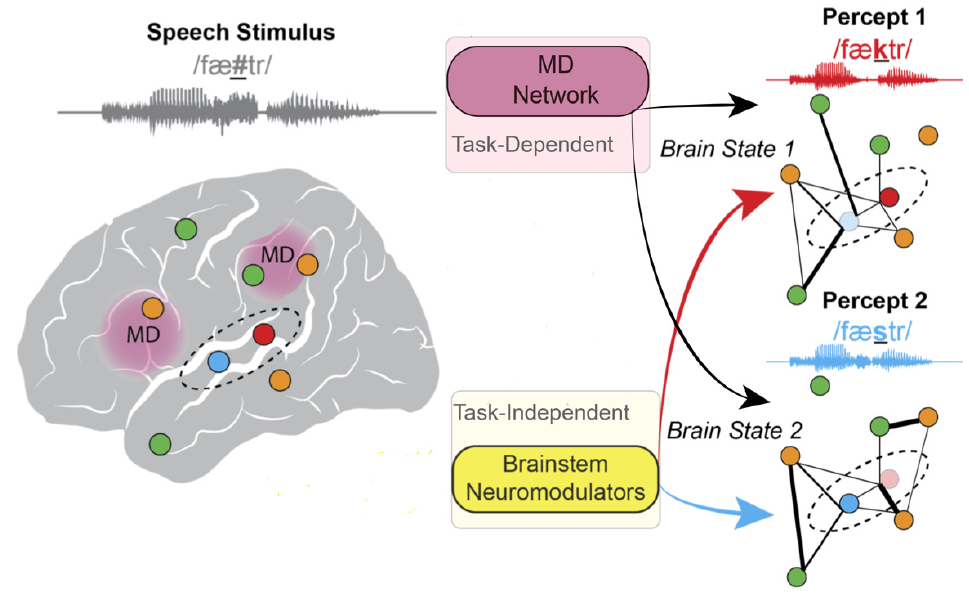
Figure 2. Trial-by-trial variability in perception is modulated by cortical brain states driven by arousal. Arousal state is mediated by the release of brainstem neuromodulators (such as nore- pinephrine; yellow box). Changes in arousal alter activity in numerous cortical sites including core speech cortex/STG (blue and red circles), non-core speech processing regions (green circles), and cortical structures comprising the Multiple Demand (MD) network (orange circles). An ambiguous stimulus (e.g., /fæ#t ɚ /) may be perceived in multiple ways depending on moment-to-moment vari- ability in brain states, the strength and configuration of functional networks (denoted by line thick- ness), and activity within cortical nodes tuned to specific features (shaded blue and red circles).